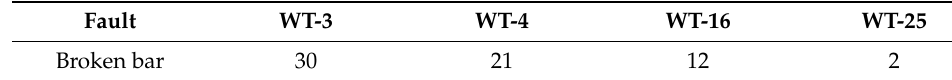
Table 5. Number of samples with trace of failure.